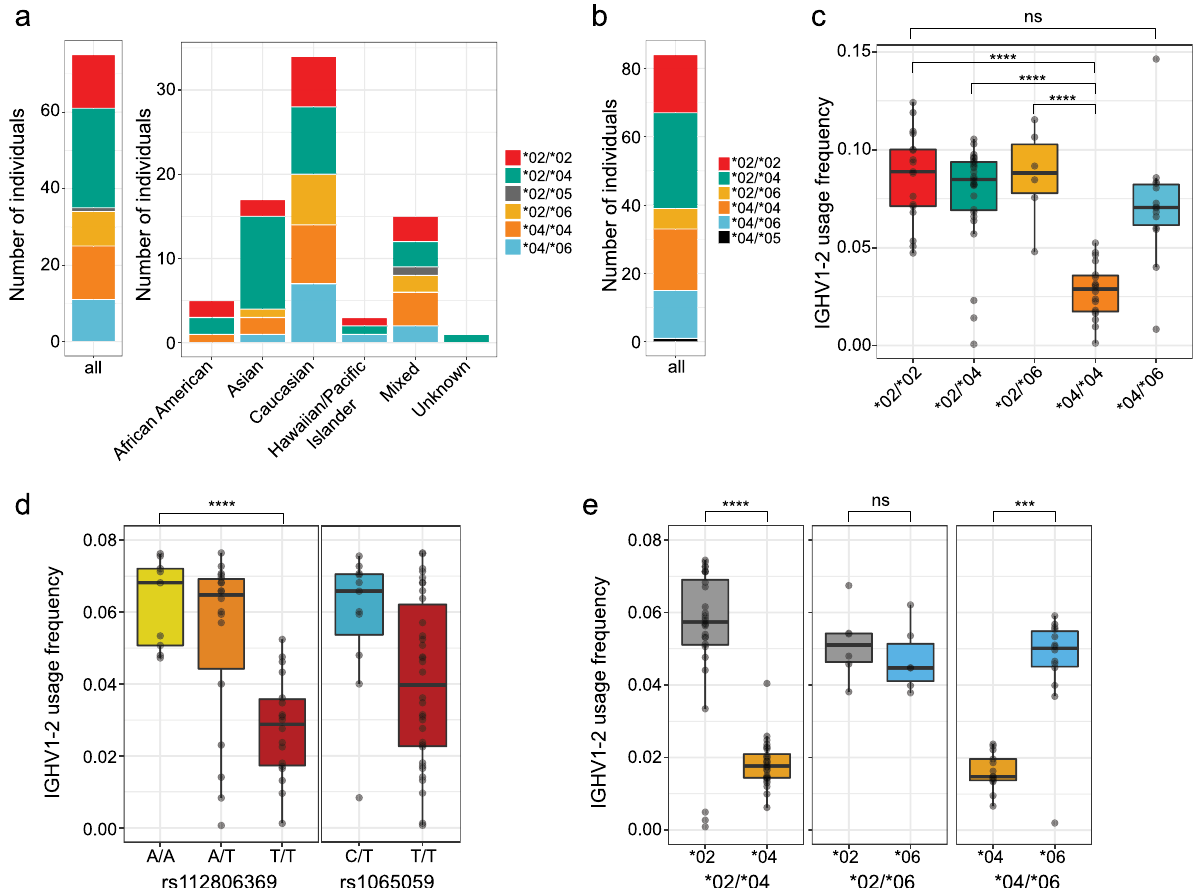
Fig. 5 Population-level IGHV1-2 genotype frequencies and allele-speci fi c effects on naive antibody repertoire usage. a Number of individuals of each inferred IGHV1-2 genotype in the collective cohort (left) and within each population subgroup (right), based on allele inferences made using RNA-seq data ( n = 75 donors). b Number of individuals of each IGHV1-2 genotype based on inferences made from IgM/ IgD expressed antibody RepSeq data ( n = 84 donors). c IGHV1-2 gene usage within the IgM/IgD repertoire partitioned by IGHV1-2 genotype ( n = 83 donors). d IGHV1-2 gene usage in the IgM/IgD repertoire partitioned by genotypes at SNPs rs112806369 and rs1065059 ( n = 83 donors). e IGHV1-2 allele-speci fi c usage within the IgM/IgD repertoire in IGHV1-2 heterozygotes (*02/*04, n = 28 donors; *02/*06, n = 6; *04/ *06, n = 14). All boxplots are plotted as follows: center line, median; box limits, upper and lower quartiles; whiskers, 1.5× interquartile range; points outside the whiskers, outliers. One-way ANOVA: *** P < 0.0001; **** P < 0.00001; ns not signi fi